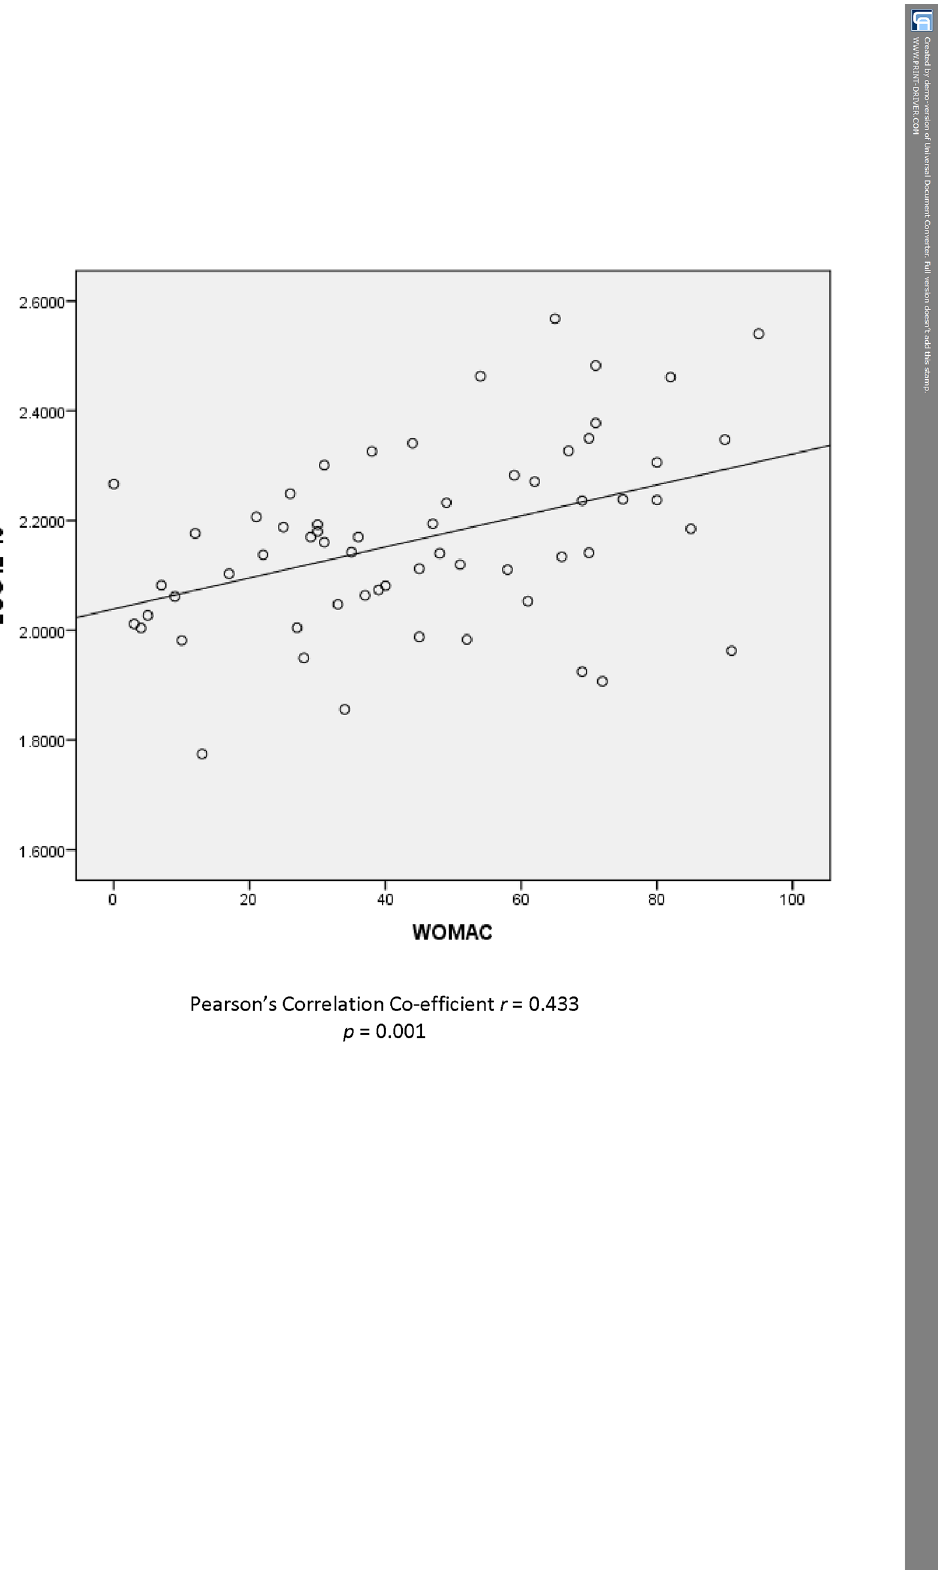
Fig 1. Correlation between IL-16 and WOMAC in patients with knee osteoarthritis. https://doi.org/10.1371/journal.pone.0184802.g001 PLOS ONE | https://doi.org/10.1371/journal.pone.0184802 September 14,